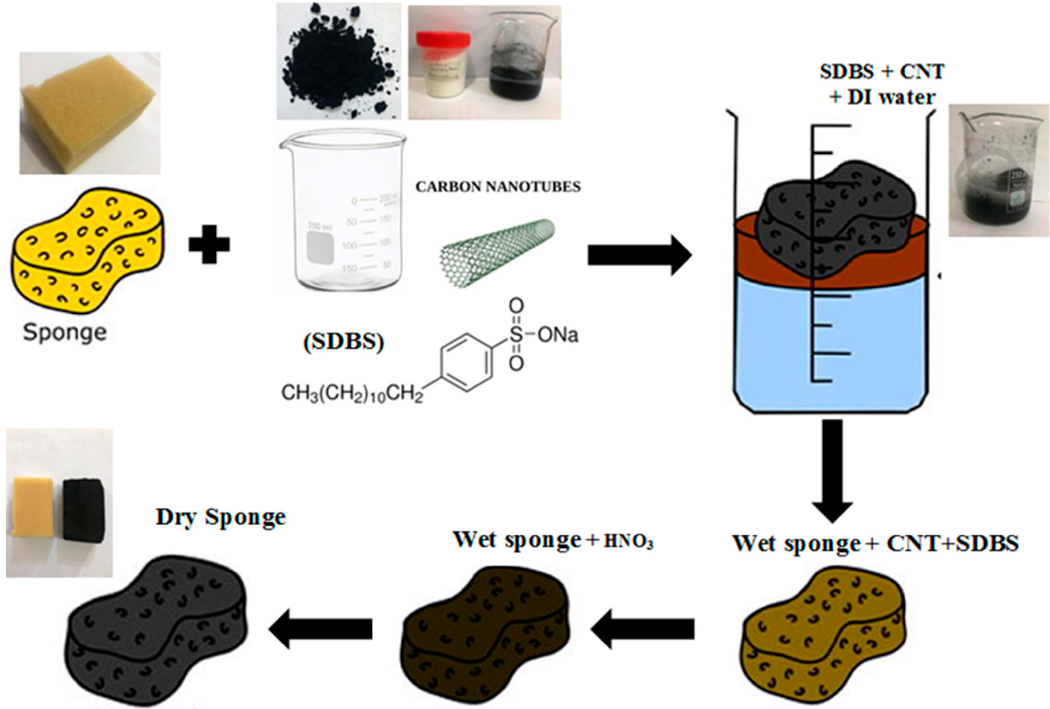
Figure 1. Schematic diagram of the fabrication process.